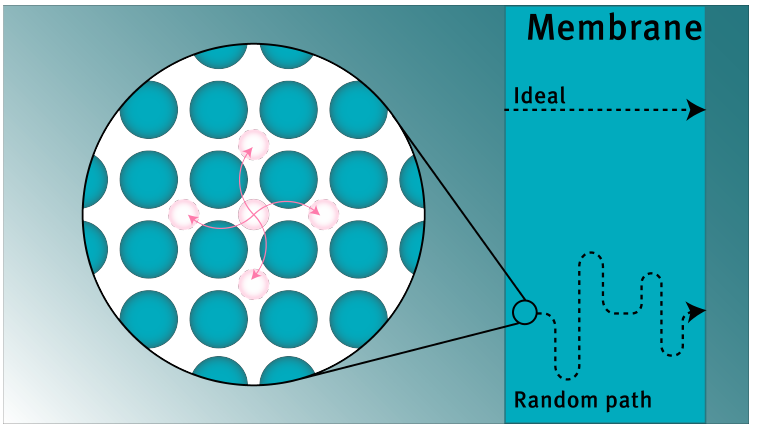
Figure 2. Schematic representation of the equal jumping probability towards all directions, and the resulting random path that the interstitial will